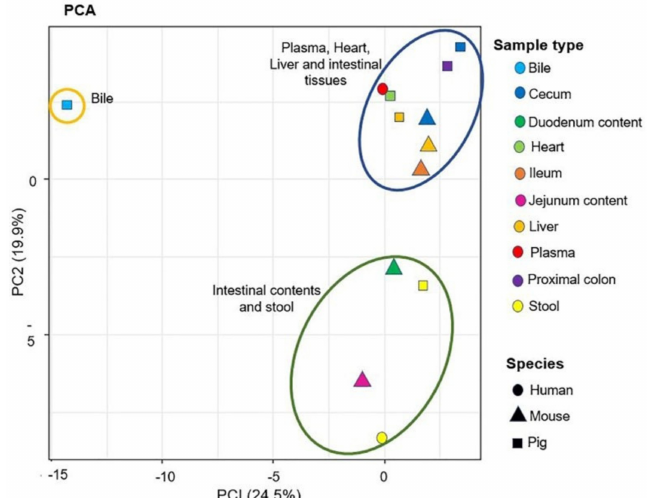
Figure 9. Principal component analysis (PCA) of the biological samples analyzed in the positive ionization mode. This figure contains the first two principal components and their scores PC1 and PC2, which explain 24.5% and 19.9% of the variation within the data, respectively. The shapes denote the different species and the colors denote the sample types. The plot shows three clusters (statistical significance not evaluated): blue ellipse—plasma, heart, liver, and intestinal tissues; green ellipse—intestinal content and stool samples; brown